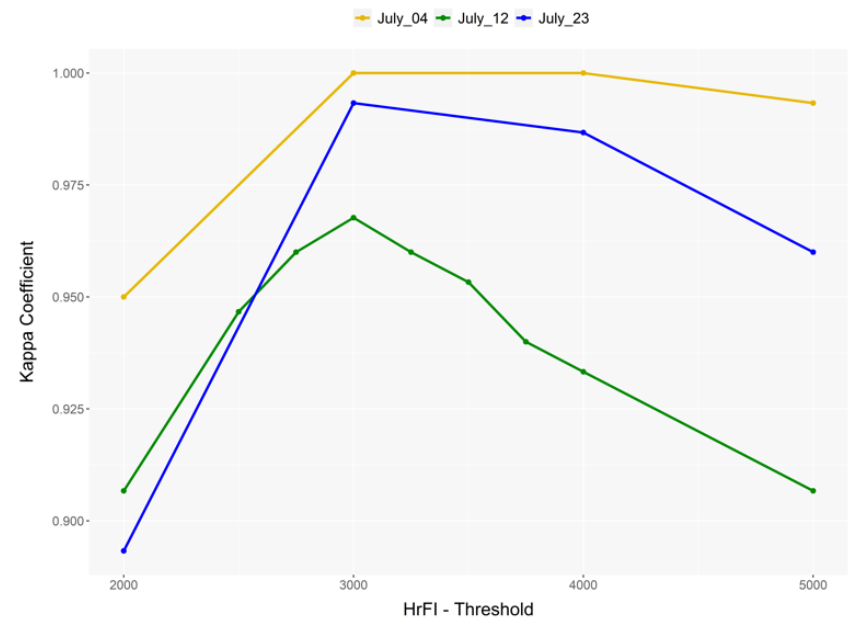
Figure 7. The variation of kappa coefficient across different HrFI thresholds used in developing flower, non-flower classifications for the three image dates.